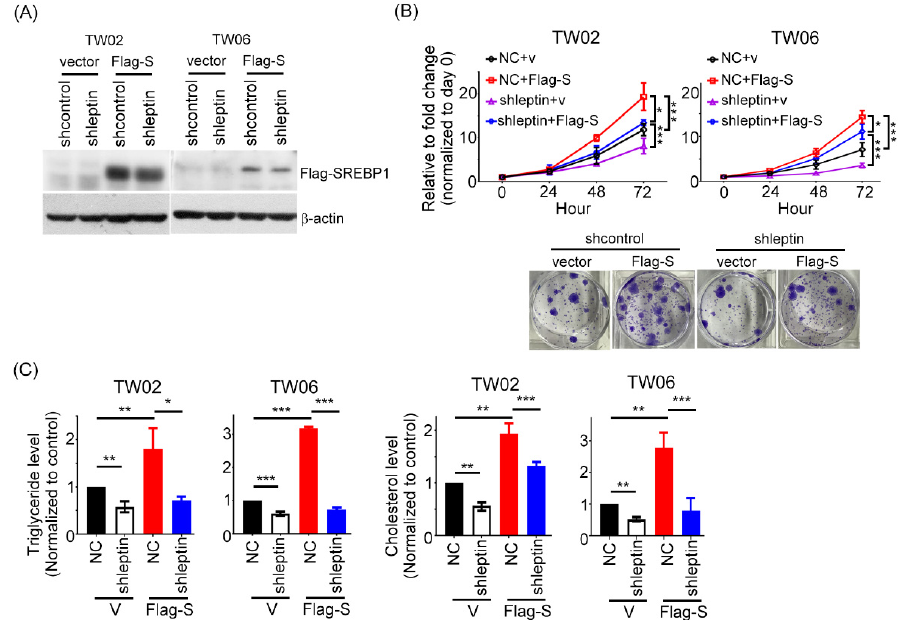
Figure 4. SREBP1 expression contributes to leptin-elicited NPC cell proliferation and lipogenesis. ( A ) Western blotting analysis of SREBP1 expression levels in shleptin-TW02 and shleptin-TW06 cells transfected with a vector alone or SREBP1 plasmid. ( B ) The CCK8 and colony formation assays determined the cell growth ability of leptin-silenced TW02 with SREBP1 expression or vector alone. ( C ) The levels of intracellular TG and cholesterol in shleptin-TW02 and shleptin-TW06 cells with SREBP1 expression were determined. v: vector; NC: shcontrol; Flag-S: Flag-SREBP1. All data were obtained from three independent experiments. Data are presented as the mean ± SD. *: p < 0.05; **: p < 0.01; ***: p <